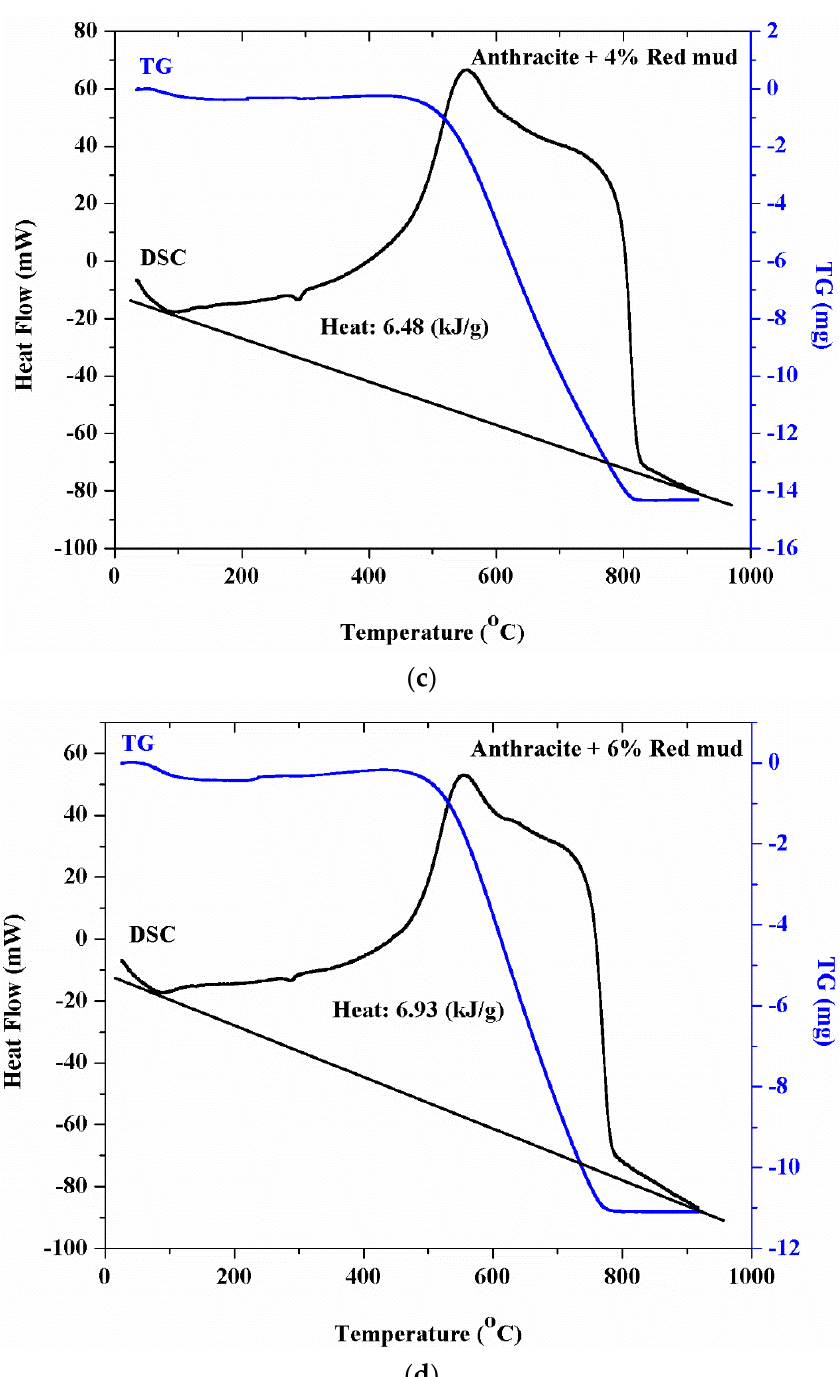
Figure 5. DSC lines of anthracite with red mud: ( a ) Raw anthracite; ( b ) Anthracite + 2% red mud; ( c ) Anthracite + 4% red mud; ( d ) Anthracite + 6% red mud.